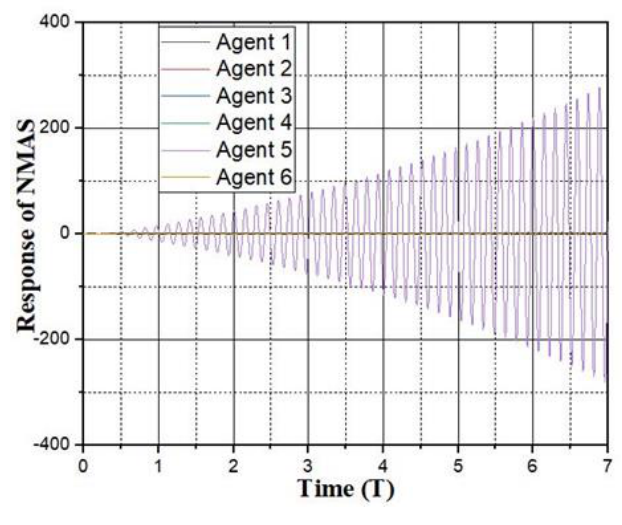
Fig. 4: Convergent response when delay = 0